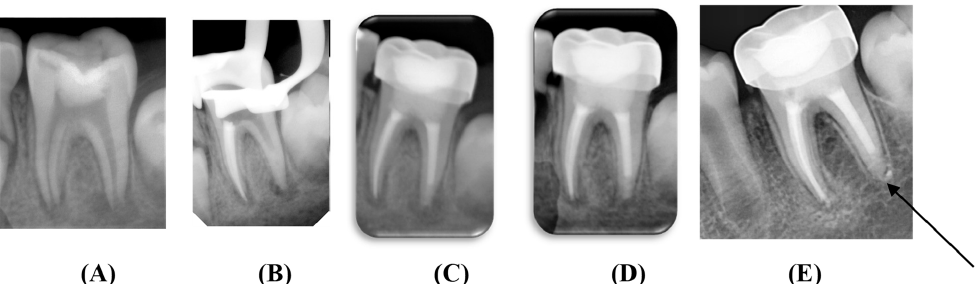
Figure 5. Apexification using Biodentine as an apical plug: ( A ) preoperative; ( B ) after placement of the apical plug; ( C ) postoperative; ( D ) 6 months follow-up; ( E ) 12 months follow-up. The arrow demonstrates the formation of apical barrier.